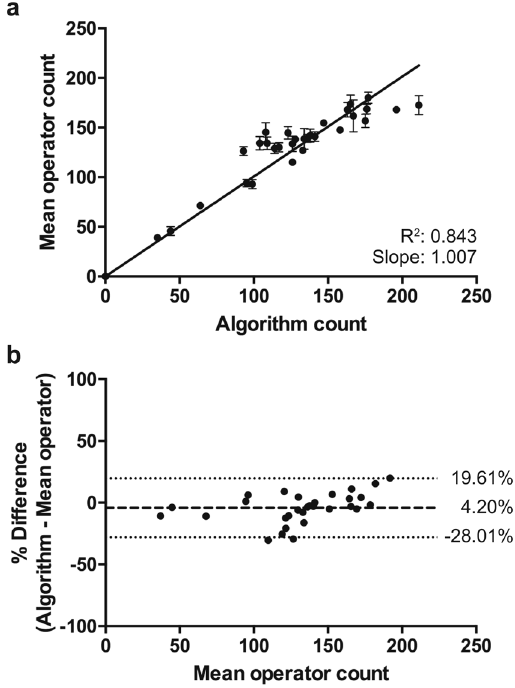
Figure 1. Algorithm optimization. ( a ) Linear fit of the mean operator counts versus the numbers of microglia detected by the automated algorithm, reveals a strong correlation (y = 1.007x; R 2 = 0.843) and validates our algorithm. ( b ) This is confirmed by the Bland-Altman plot, which shows a bias of 4.20%. For comparison, bias for three observers was − 8.35%, 4.33% and 3.50%. Data are depicted as mean ± 95% confidence intervals.